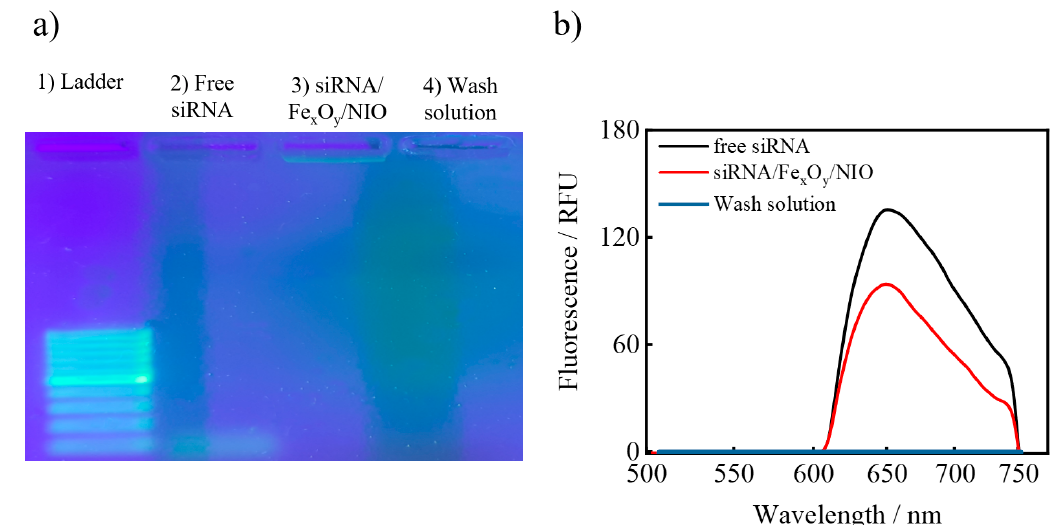
Figure 4. ( a ) Stained agarose gel after electrophoresis of the (1) ladder, (2) free siRNA, (3) siRNA/Fe x O y /NIOs and (4) wash solution; ( b ) fluorescence spectrum of SYBR Green I-stained free siRNA, siRNA/Fe x O y /NIO and the wash solution.